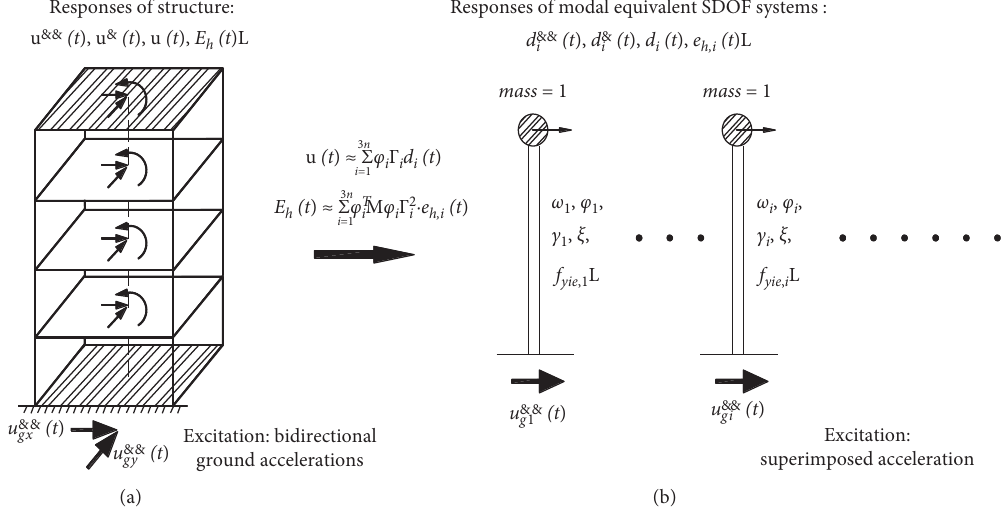
Figure 2: The relation between (a) structure and (b) modal equivalent SDOF